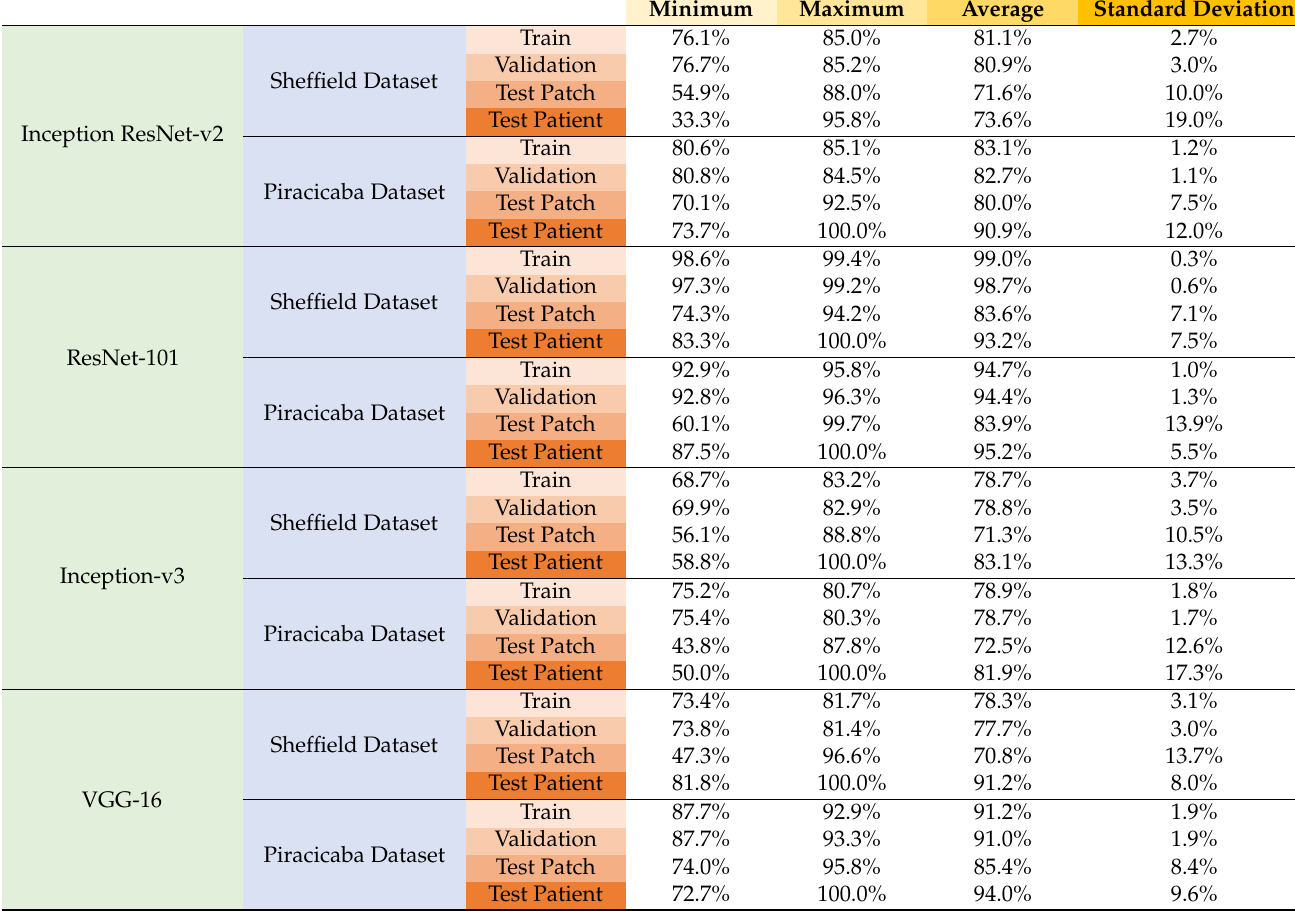
Table 3. Ten-fold cross-validation results for Sheffield and Piracicaba datasets.